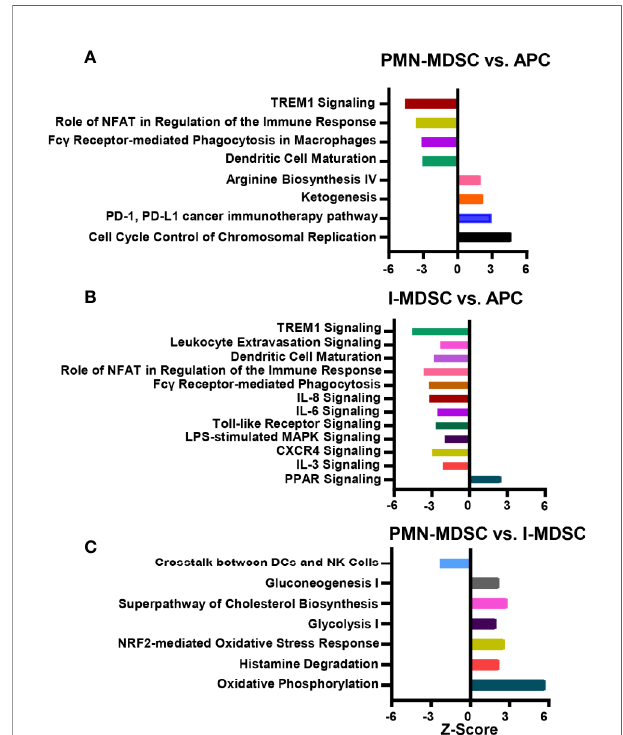
FIGURE 4 | Canonical and signaling pathway analyses of myeloid subpopulations in the CRC tumor microenvironment. Functional categorization of top signi fi cantly upregulated and downregulated transcripts (with a fold change > 2, P value cutoff < 0.05) from CLC analysis were analyzed through IPA. Top signi fi cantly affected (1.5 > Z score < -2.0) canonical pathways were analyzed by IPA. The horizontal bars denote the different pathways based on the Z-scores; PMN-MDSC vs. APC (A) , I-MDSC vs. APC (B) and PMN-MDSC vs. I-MDSC (C)